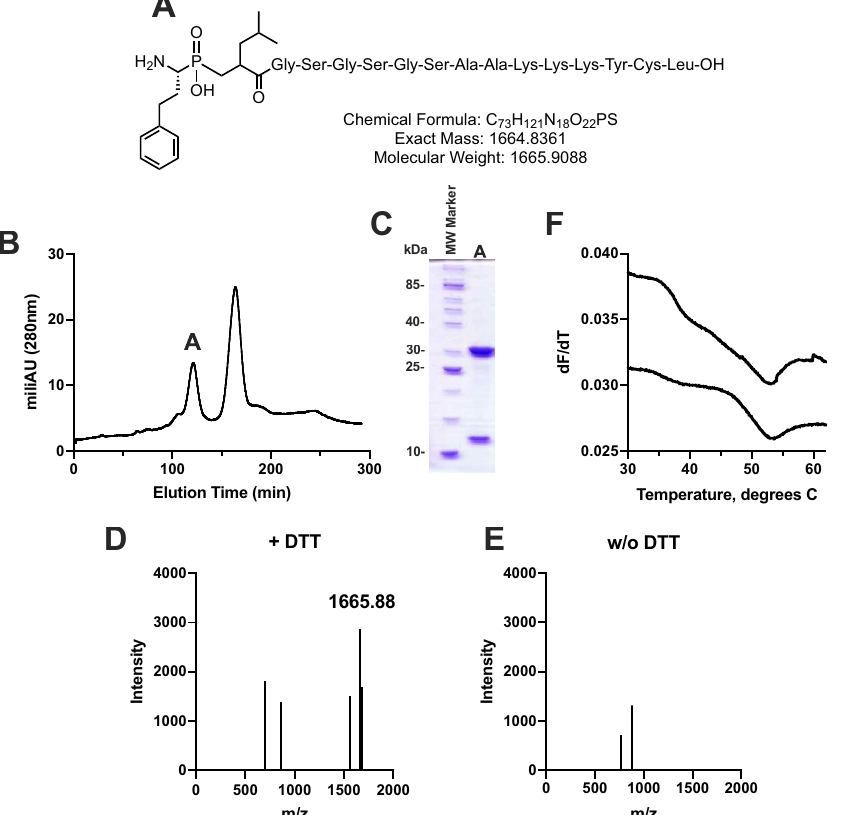
Figure 3. Construction of a disulfide-linked HLA-B*08/ phosphinic peptide complex. Panel ( A ) chemical structure of phosphinic pseudopeptide DG080. Panel ( B ) size-exclusion chromatogram of the refolding mixture of HLA-B*08(E76C) with DG080. Panel ( C ) SDS-PAGE analysis of peak A from the size-exclusion chromatogram shown in panel ( B ). Panel ( D ) MALDI-TOF–MS analysis of purified complex in the presence of 100 mM DTT. Panel ( E ) MALDI-TOF–MS analysis of purified complex in the absence of DTT. Panel ( F ) 1st derivative of thermal shift assay of purified complex (two representative experiments